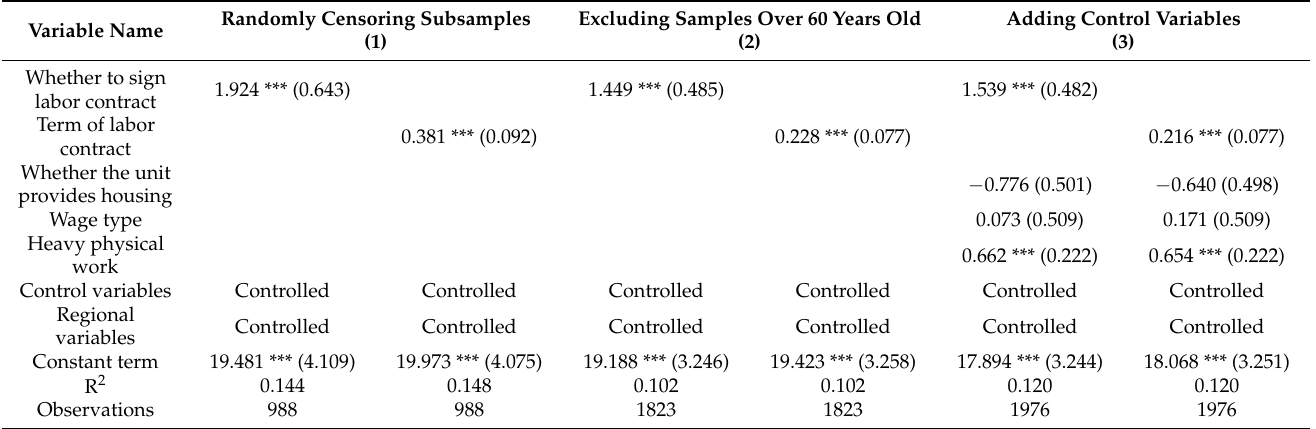
Table 5. Robustness test of the impact of the labor contract on the urban integration of migrant